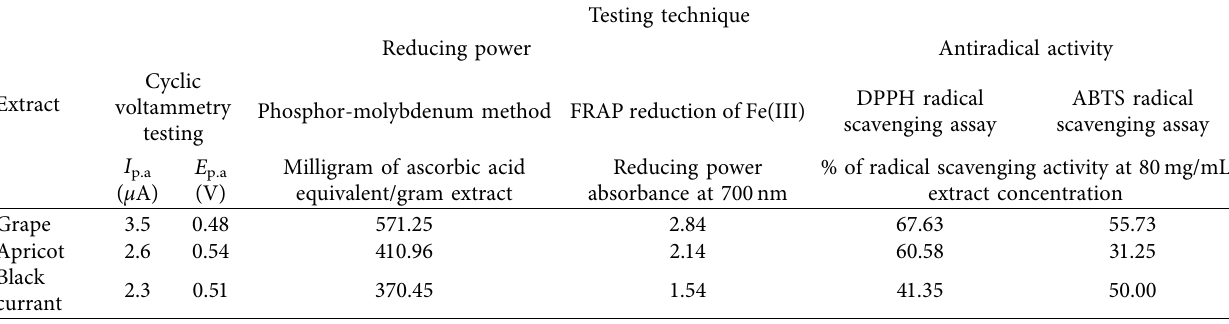
Table 7: The reducing power and the radical scavenging activity of the extract.